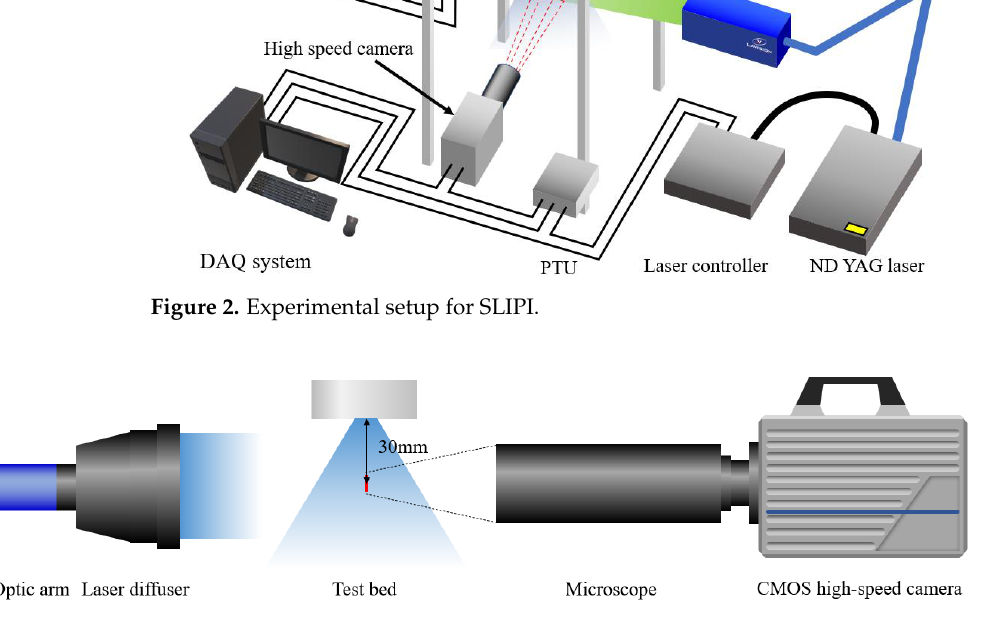
Figure 3. Experimental apparatus for droplet size